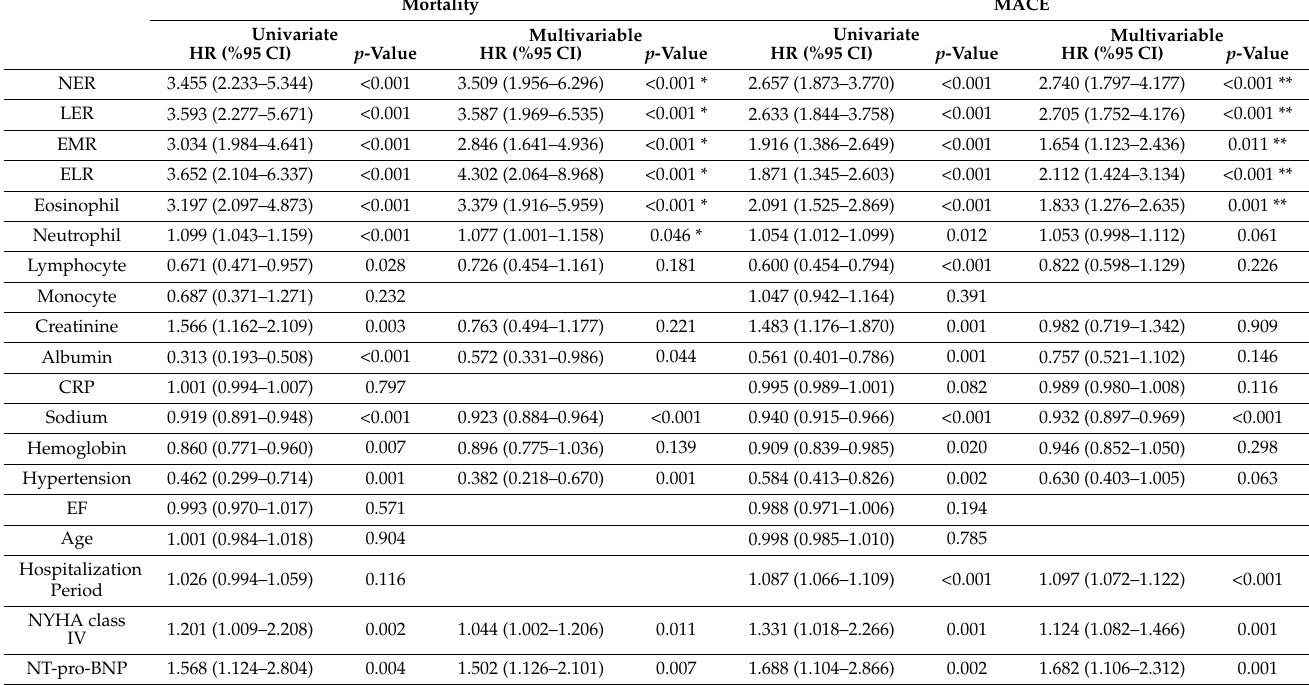
Table 4. Results of univariate and multivariable Cox regression analysis for the determination of mortality and MACE independent